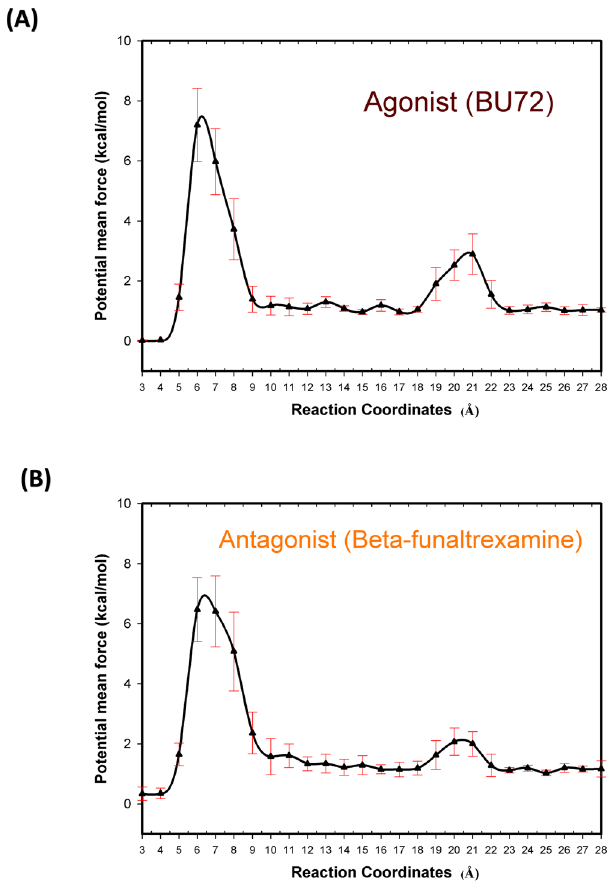
Figure 1. Free energy profiles (PMF) of reaction coordinates. The PMF profiles were calculated with five individual 1000-ns GaMD simulations. ( A ) Agonist (BU72) ( B ) Antagonist (Beta-funaltrexamine).